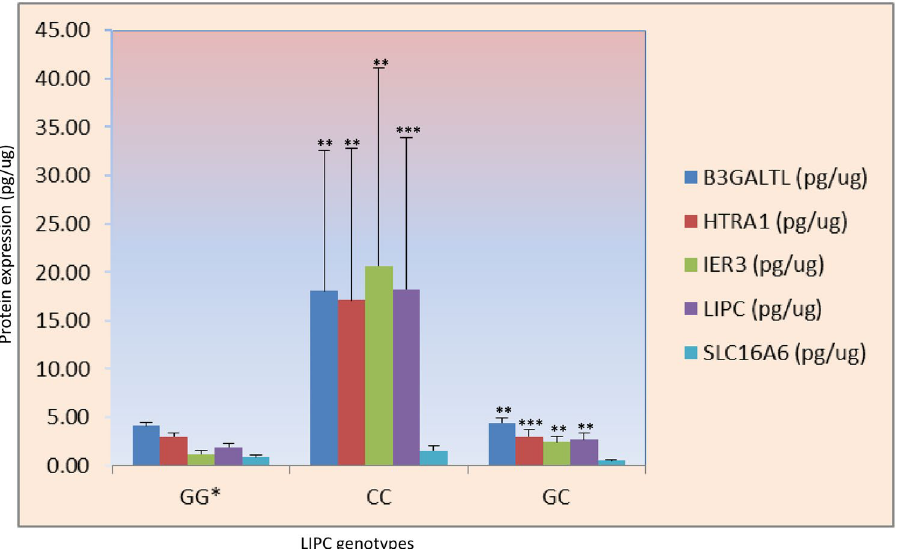
Figure 2. Impact of LIPC genotype on protein expression. Significant elevated expressions of B3GALTL, HTRA1, IER3 and LIPC were seen in ‘CC’ genotype of LIPC genetic variant (rs920915) as compared to both